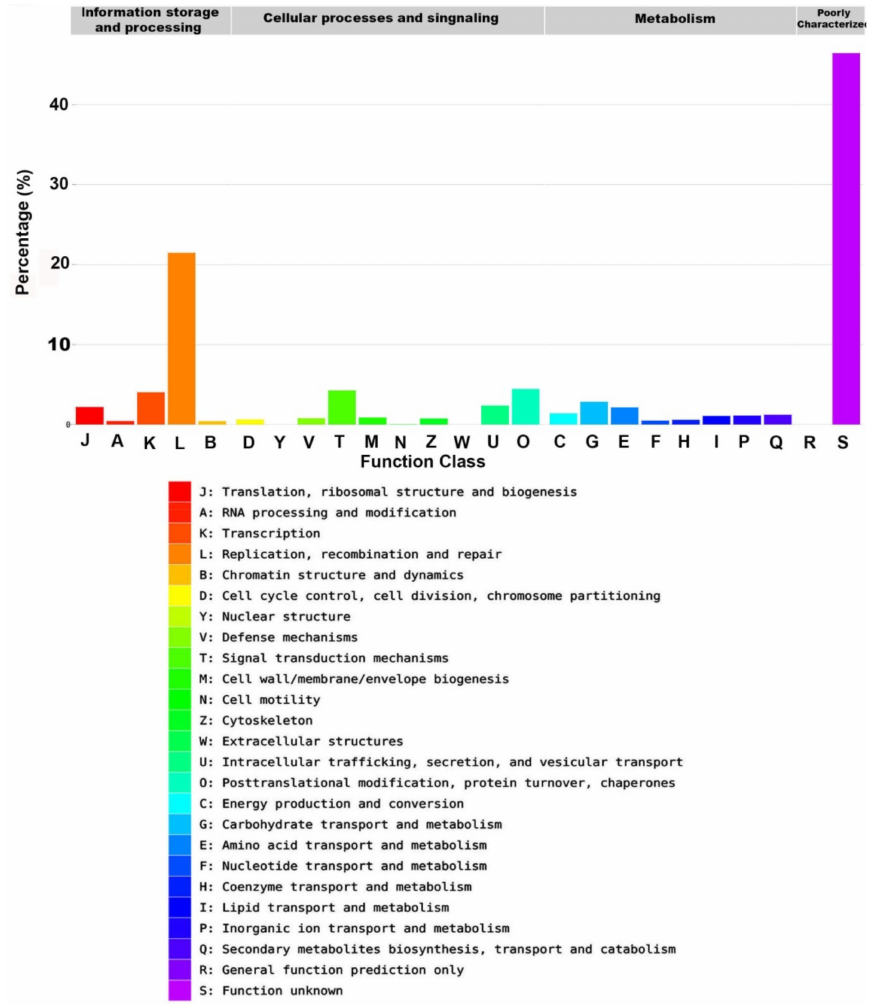
Figure 6. The annotated sequence percentage of detected unigenes against the Evolutionary genealogy of genes: Non-supervised Orthologous Groups (EggNOG)